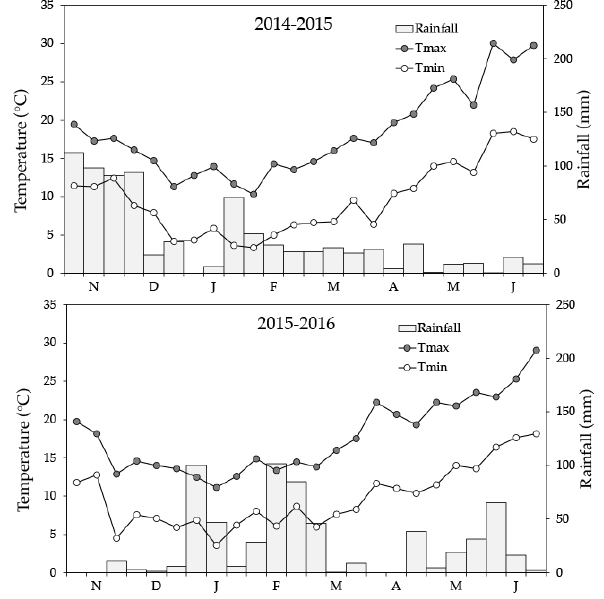
Figure 1. Rainfall ten-day data and minimum and maximum air temperatures during the growth cycle of wheat in 2014–2015 (up) and 2015–2016 (down) at the experimental sites in San Piero a Grado, Pisa, Italy. The data were collected from a nearby weather station Bocca d’Arno, Pisa. For each experiment, a three-factorial experimental design with genotype [seven bread wheat ( Triticum aestivum L.) genotypes with different years of release (Table 1)], AM fungal inoculation (AM fungal inoculation, +M; mock-inoculated, -M), and year of cultivation (Y) was arranged as a split-plot design, with AM fungal inoculation as the main plot factor and genotype as the split-plot factor. Three replicate plots were set up. The area of each plot was 100 m 2 (10 m × 10 m). AM fungal inoculation was carried out by coating the seeds with 0.55 g m − 2 (5556 spore m − 2 ) of Rhizophagus irregularis MUCL43194. Nitrogen fertilizer was applied, as urea, at tillering and at stem elongation at 40 and 40 kg N ha − 1 , respectively. Table 1. List of the genetic material including information on year of release (YR), pedigree, glutenin configuration, and score quality.